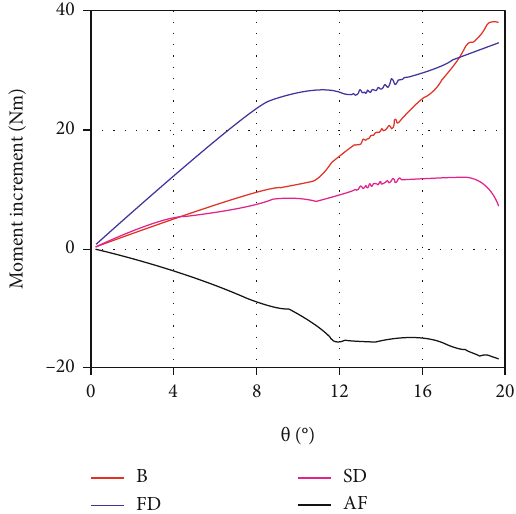
Figure 11: The moment increments in the erection state of the body (B), fi rst dorsal (FD), second dorsal (SD), and anal fi ns (AF) under the quasistatic yaw motion ( ω = 0 : 01